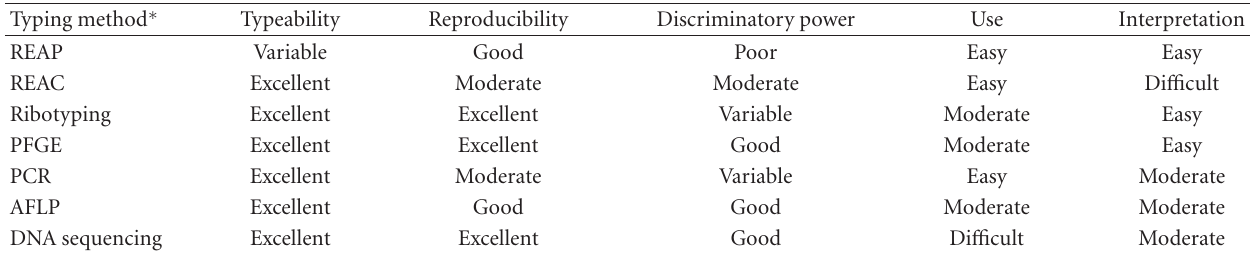
Table 3: Methods for molecular typing of Yersinia enterocolitica isolates.